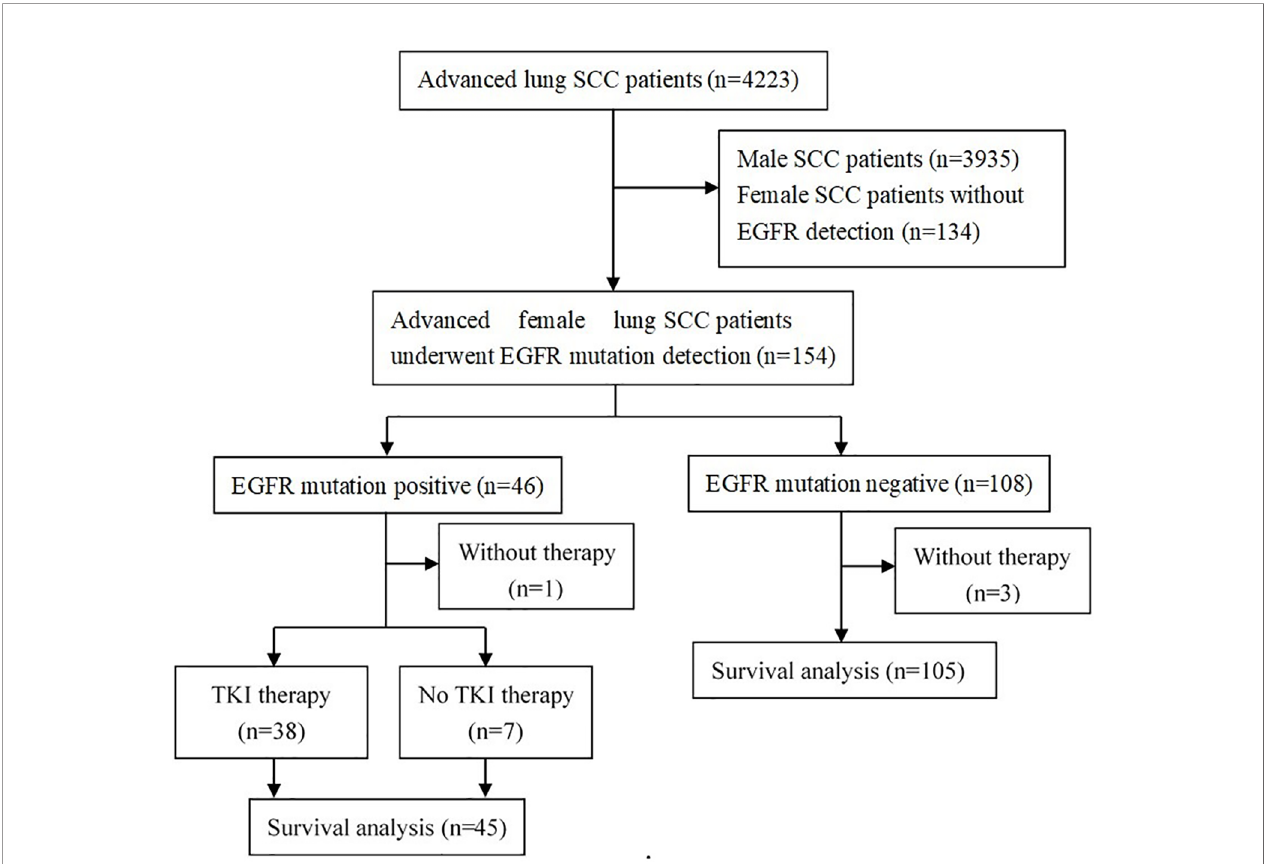
FIGURE 1 | Flow diagram of patients studied. SCC, squamous cell carcinoma; EGFR, epidermal growth factor receptor; TKI, tyrosine kinase